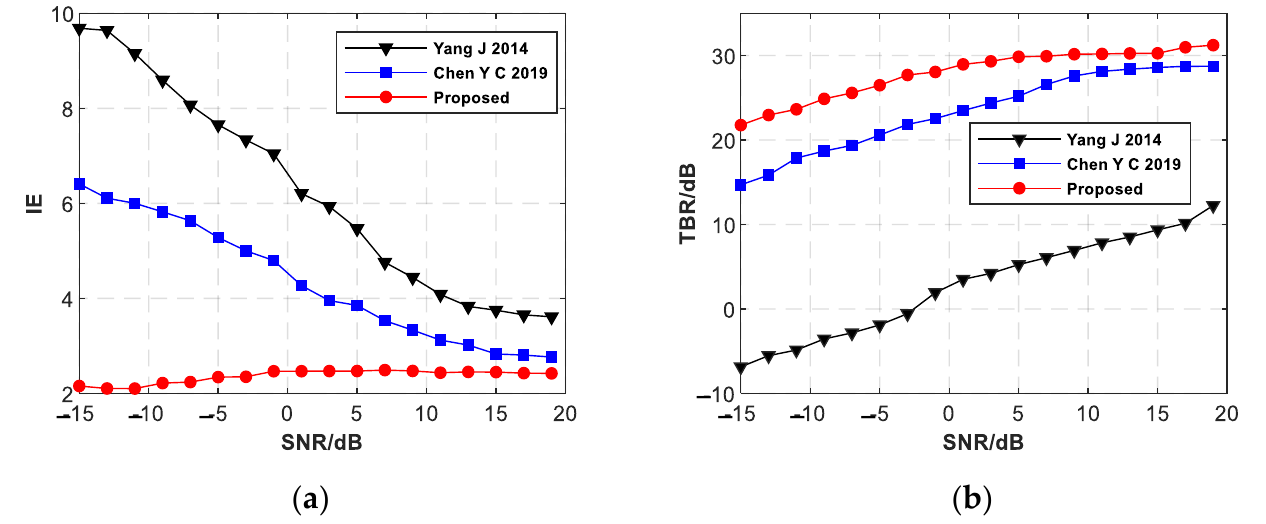
Figure 7. Performance curves of ( a ) ENT. ( b )TBR versus SNR of three methods with sampling ratio η = 0.5.